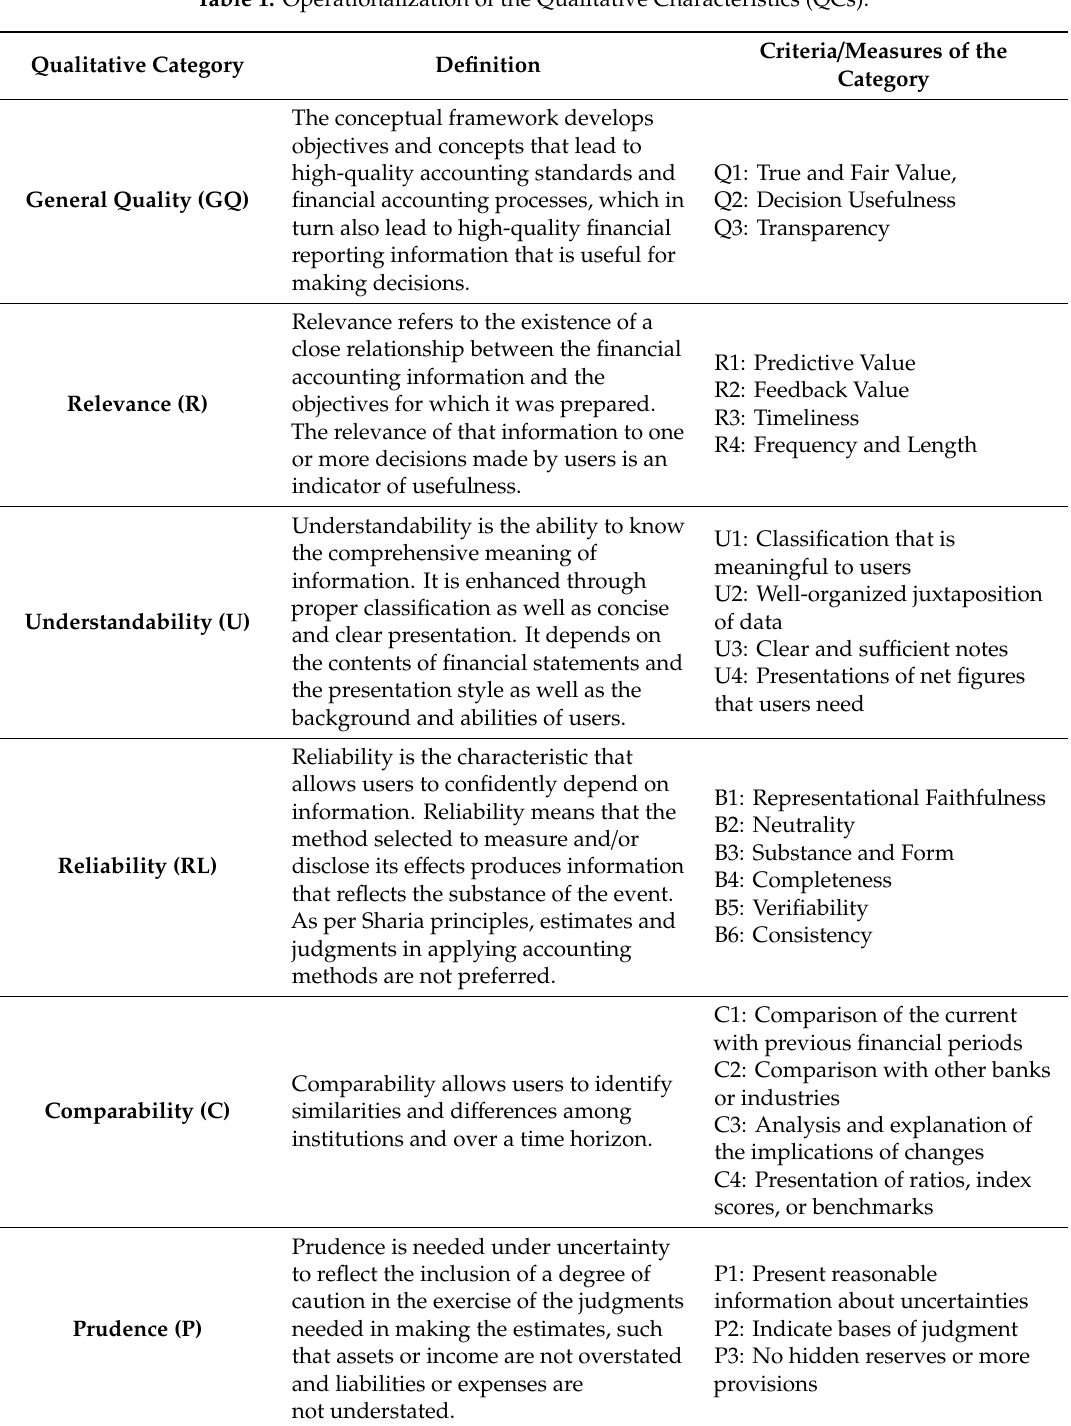
Table 1. Operationalization of the Qualitative Characteristics